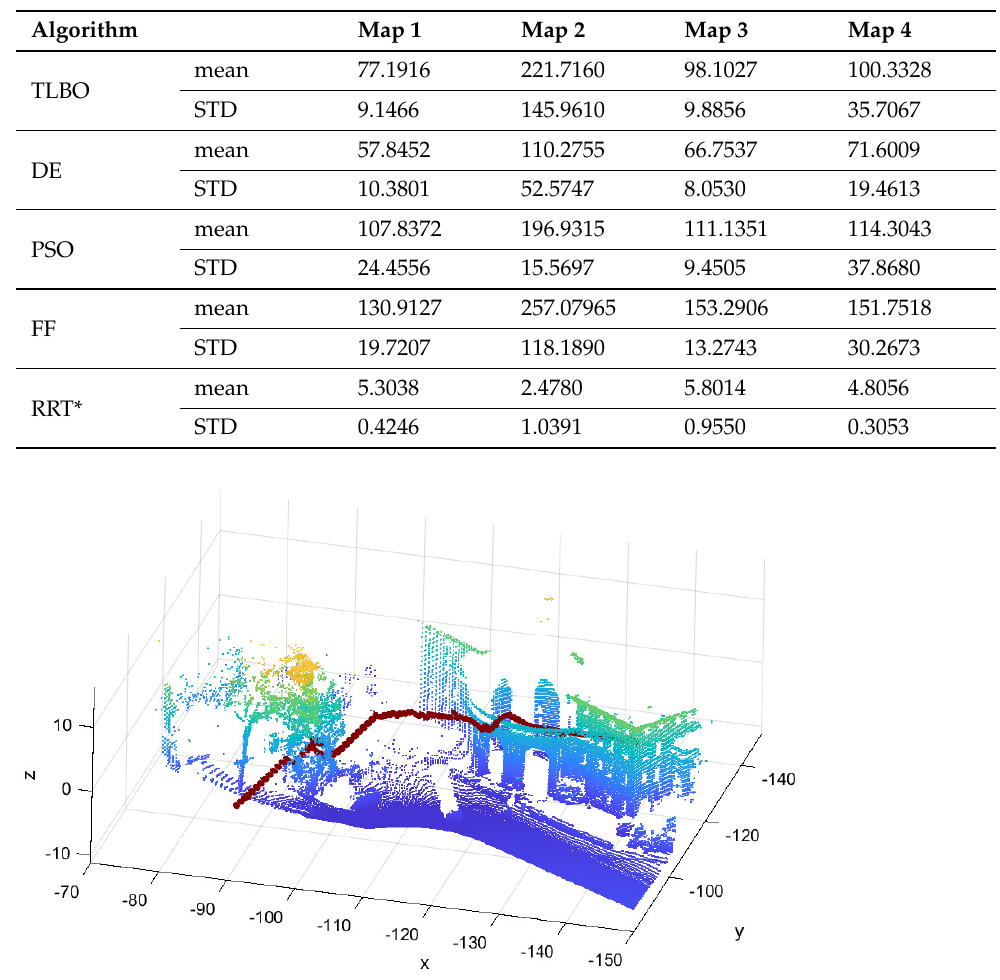
Figure 15. Path planning in a real ellipsoidal map, we show the point cloud for a better understanding of the image. The cloud point has 100,000 points but the map only has 700